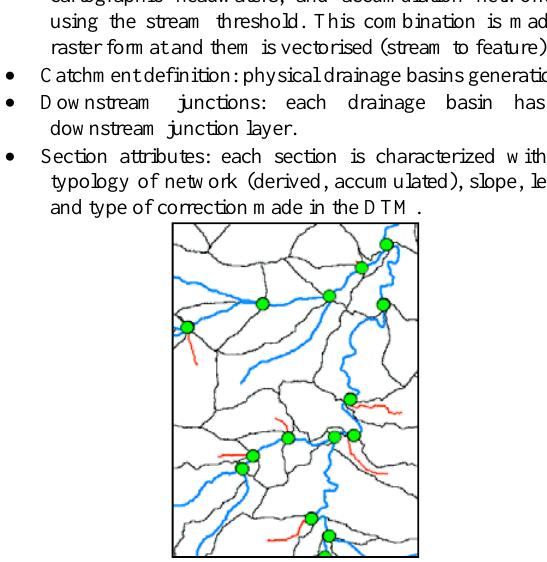
Figure 14. 2D network generation. Derived network appear in blue, accumulation network in red, catchments in black and downstream junctions for each catchment in green.